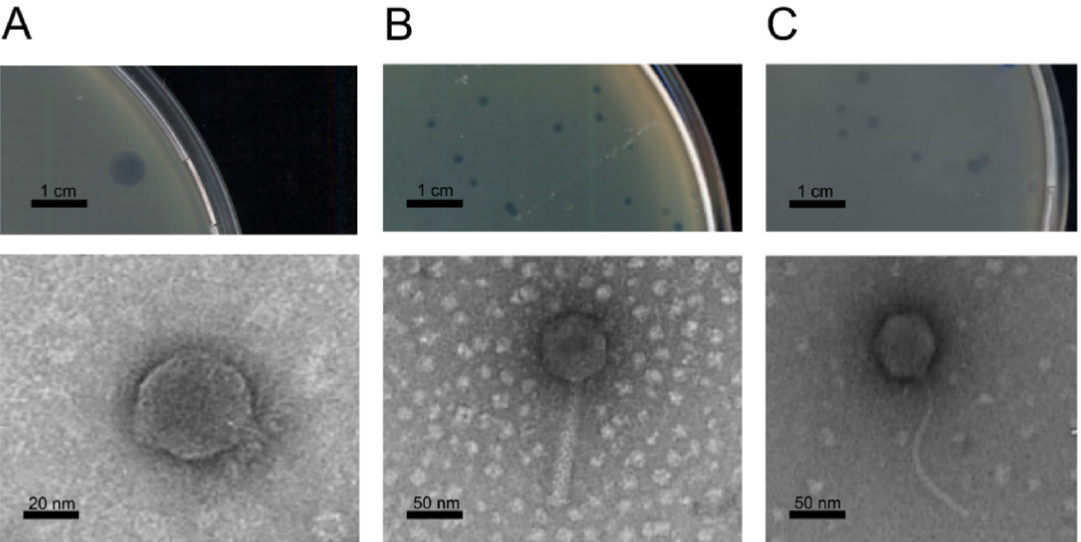
Figure 1. Plaque morphology and electron microscopy images of the three phages representing putative new species: ( A ) pphageB1 capsid has an icosahedric head with a short tail and clear fibers, typical for a podovirus morphology; ( B ) psageA1 has an icosahedral head and a putative contractile tail typical for the myovirus morphology; ( C ) psageB1 shows a long and flexible non-contractile tail linked to an icosahedral head, a typical siphovirus morphology.